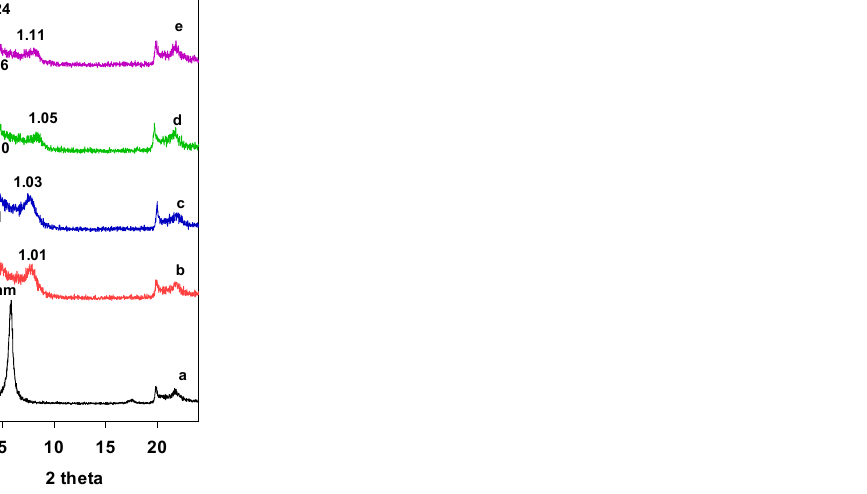
Figure 2. PXRD patterns of the Zr(X) ‐ Mt after reaction with TEOS solution and C12 amine (a) 0, (b) 3, (c) 6, (d) 12, and (e) 24. After thermal treatment at 550 °C, the d ‐ values of the precursors shifted to higher angles, due to the loss of C 12 surfactants and condensation of silica species via dihydrox ‐ ylation. A maximum value of 3.81 nm was recorded for Zr(6) ‐ PCH material (not shown). These values were comparable to those reported for PCH ones doped with variables Al contents [12]. In the case of Zr(0) ‐ PCH precursor, the d ‐ value continued to decrease to a value 1.14 nm. This value was larger than the value of raw clay calcined at the same temperature (0.96 nm), due the existence of some silica pillars within the interlayer space of Mt clay. Figure 3 depicts the PXRD patterns of Zr(6) ‐ PCH precursor heat treated at different temperatures. Calcination at 550 °C, the value of the d 001 value did not change, however, at 650 °C, the intensity of the 001 reflection was drastically reduced and the PXRD pat ‐ terns exhibited broad reflection embedded in the background of the patterns. This fact could be linked to the dehydroxylation of the clay layers host and destruction of the mesoporous silica framework or to the delaminated structure of the calcined materials